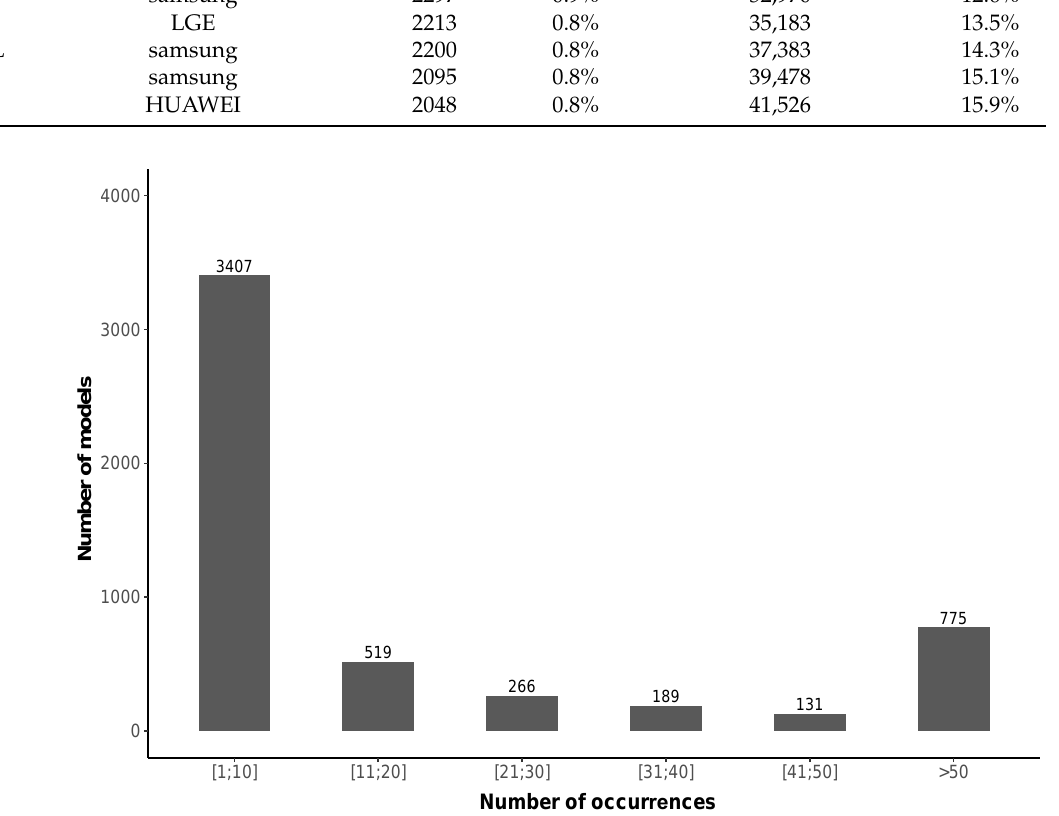
Figure 6. Distribution of the number of occurrences of a smartphone model in the database. As an example, 775 device models appear more than 50 times in the